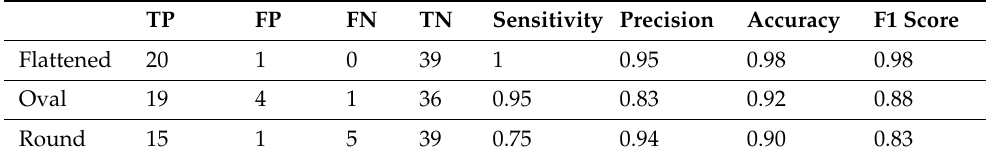
Table 3. Predictive performance measurement using the AI model for sella turcica classification of test data. TP FP FN TN Sensitivity Precision Accuracy